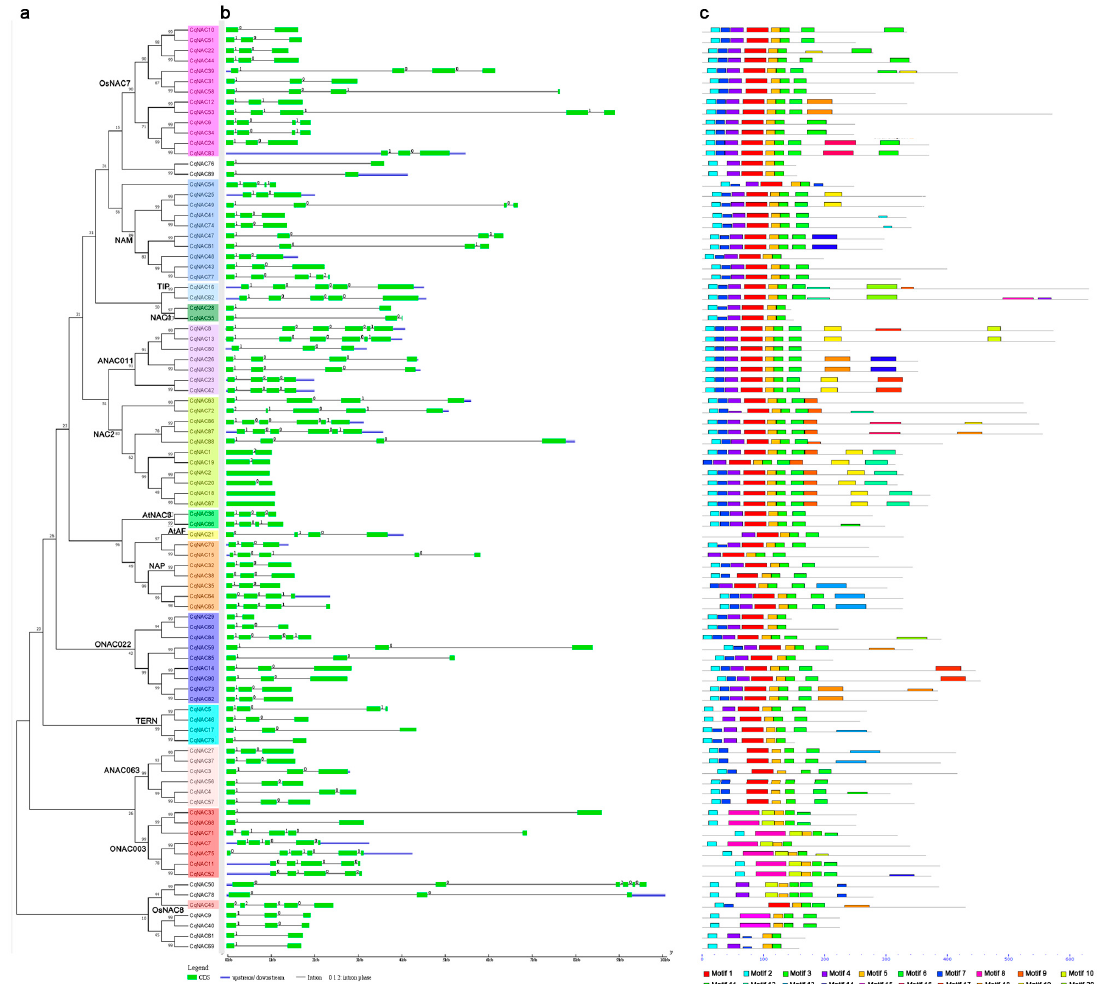
Figure 2. The gene structures and conserved motifs of CqNAC genes according to the phylogenetic relationship. The phylogenetic tree ( a ) was generated using the MEGA7 method. Gene structures of CqNACs ( b ) were predicted with GSDS software. The exons are represented by green boxes, and the introns are indicated by black lines. The conserved motifs ( c ) were identified by the MEME web server. Each motif is indicated by a colored box numbered at the bottom. The location of each motif can be estimated using the scale at the bottom.